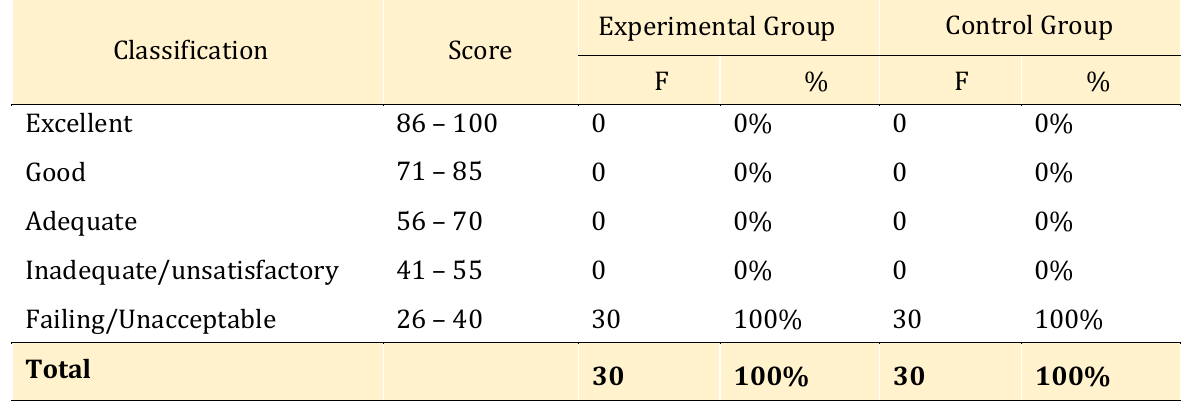
Table 8. The Rate Percentage and Frequency of Students’ Posttest Scores in